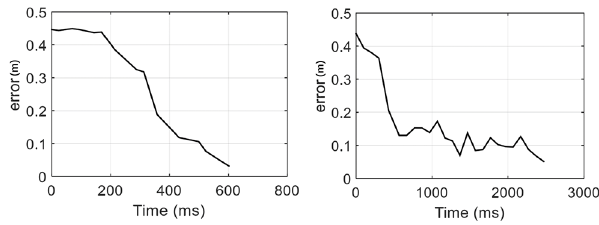
Figure 13. Error curve of 0.1 m/s ( left ) and 0.25 m/s ( right ).